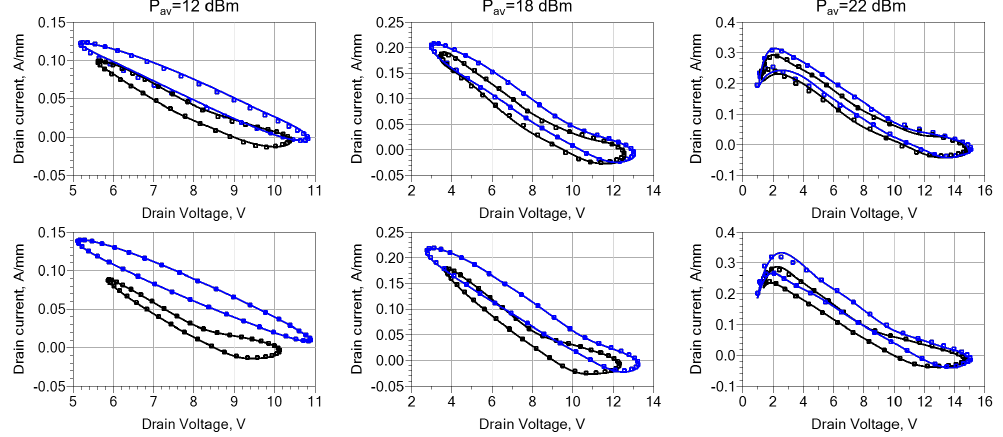
Figure 13. DLLs at the output port from TCAD (symbols) and ADS simulations with the (1NL) model (lines) with varying doping concentrations. The device is close to turn on ( P av = 12 dBm, left ), at intermediate drive ( P av = 18 dBm, center ), and in compression ( P av = 22 dBm, B). ( Top ): − 5% (black lines and symbols); +5% (blue lines and symbols). ( Bottom ): − 10% (black lines and symbols); +10% (blue lines and symbols).